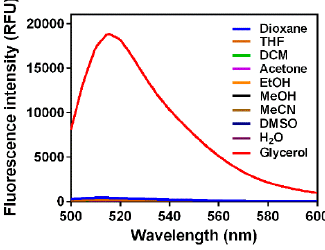
Figure 1. Fluorescence intensity of BTV (10 µM, λ ex = 470 nm, 25 °C) in different solvents.